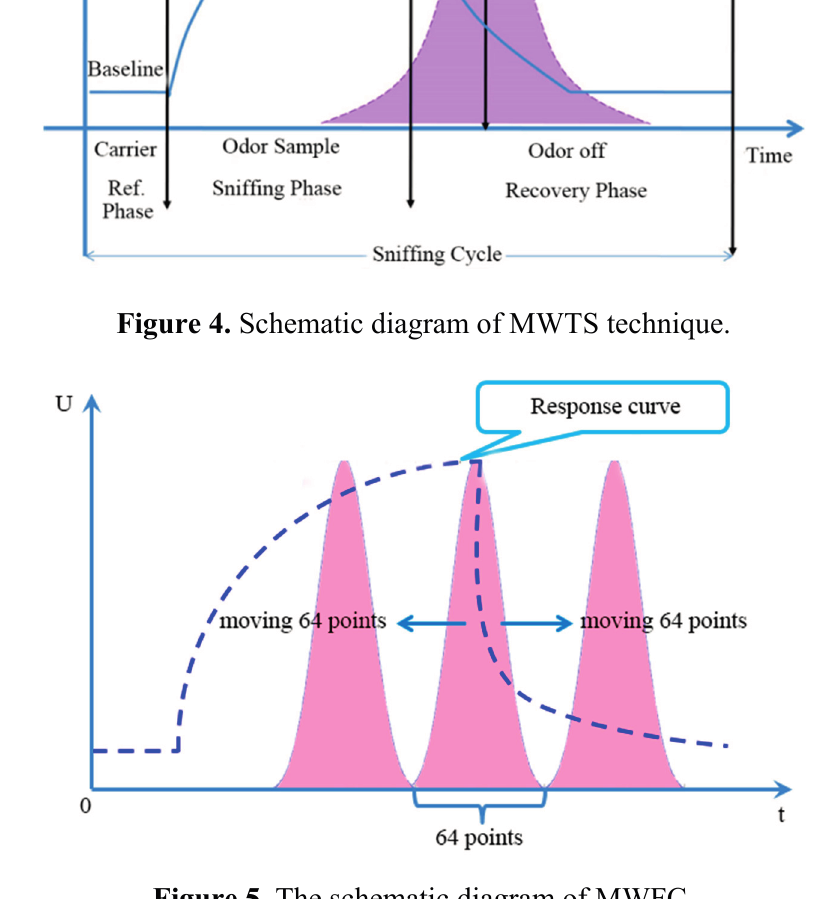
Figure 5. The schematic diagram of MWFC. Table 14. Classification rates (CR) of different features in